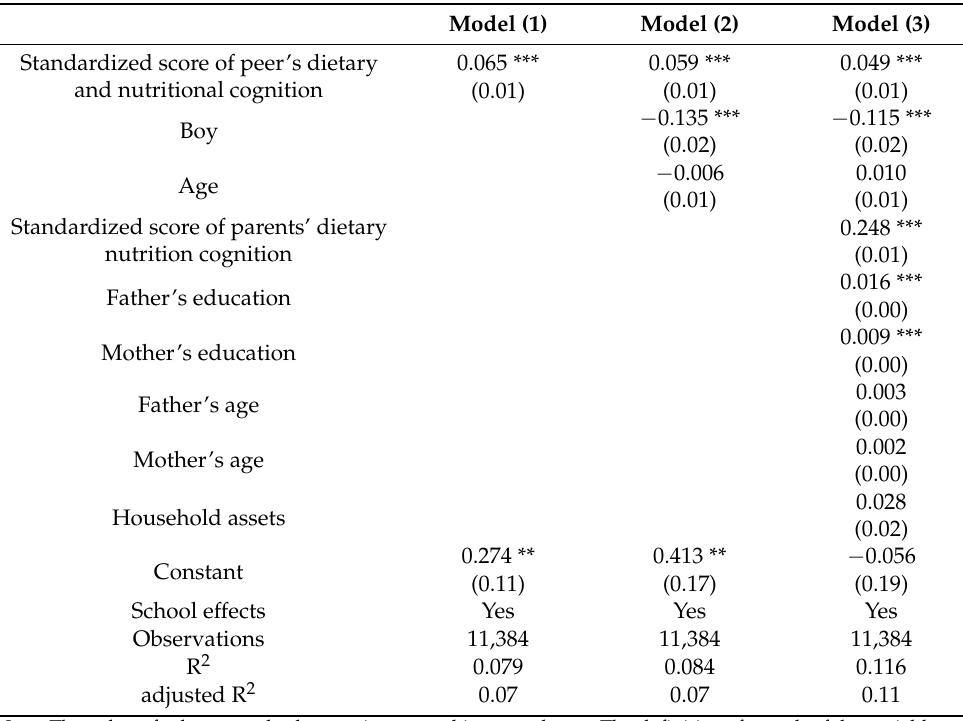
Table 2. Relationship between peer’s dietary and nutritional cognition and student’s dietary and nutritional cognition.